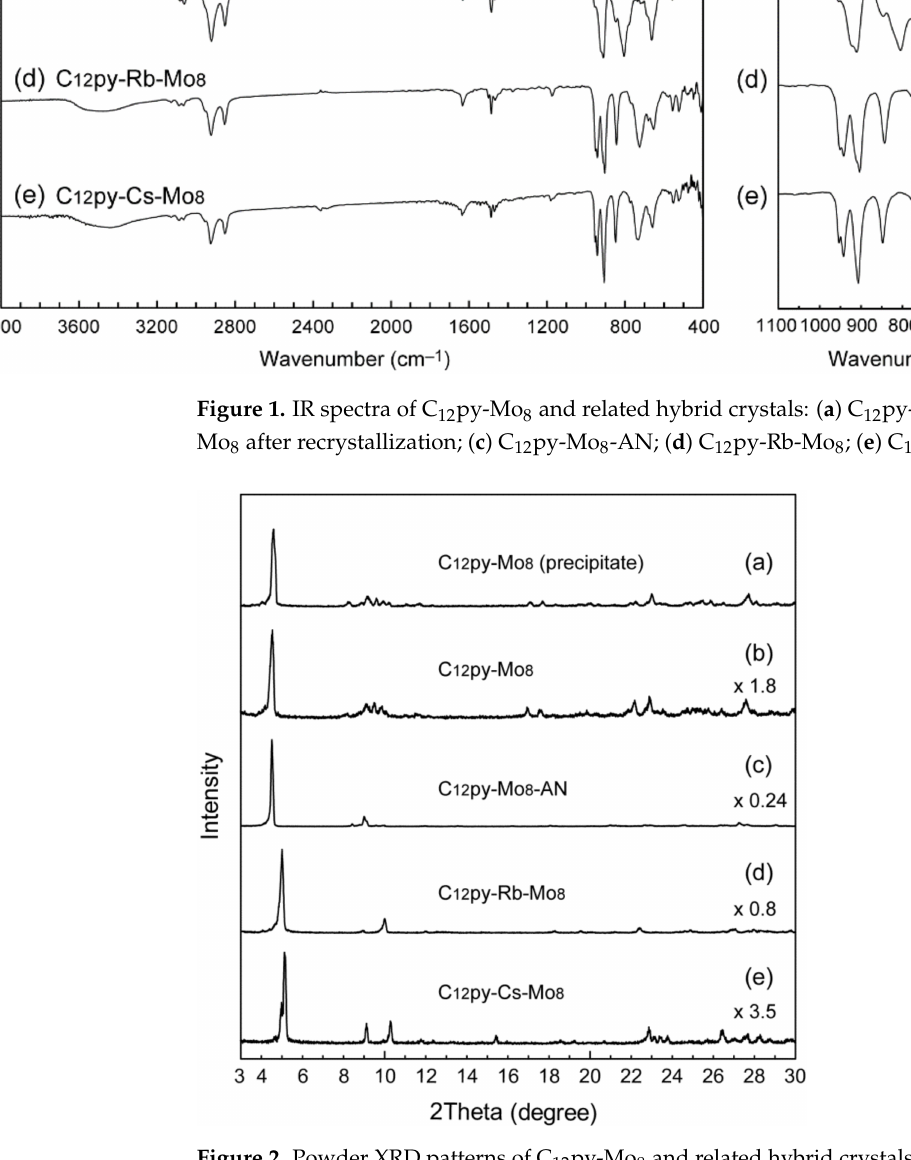
Figure 2. Powder XRD patterns of C 12 py-Mo 8 and related hybrid crystals: ( a ) C 12 py-Mo 8 precipitate; ( b ) C 12 py-Mo 8 after recrystallization; ( c ) C 12 py-Mo 8 -AN; ( d ) C 12 py-Rb-Mo 8 ; ( e ) C 12 py-Cs-Mo 8